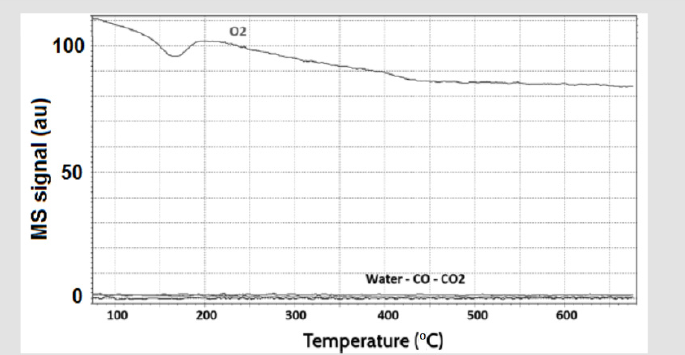
Figure 13. TPO spectrum on the fresh catalyst.